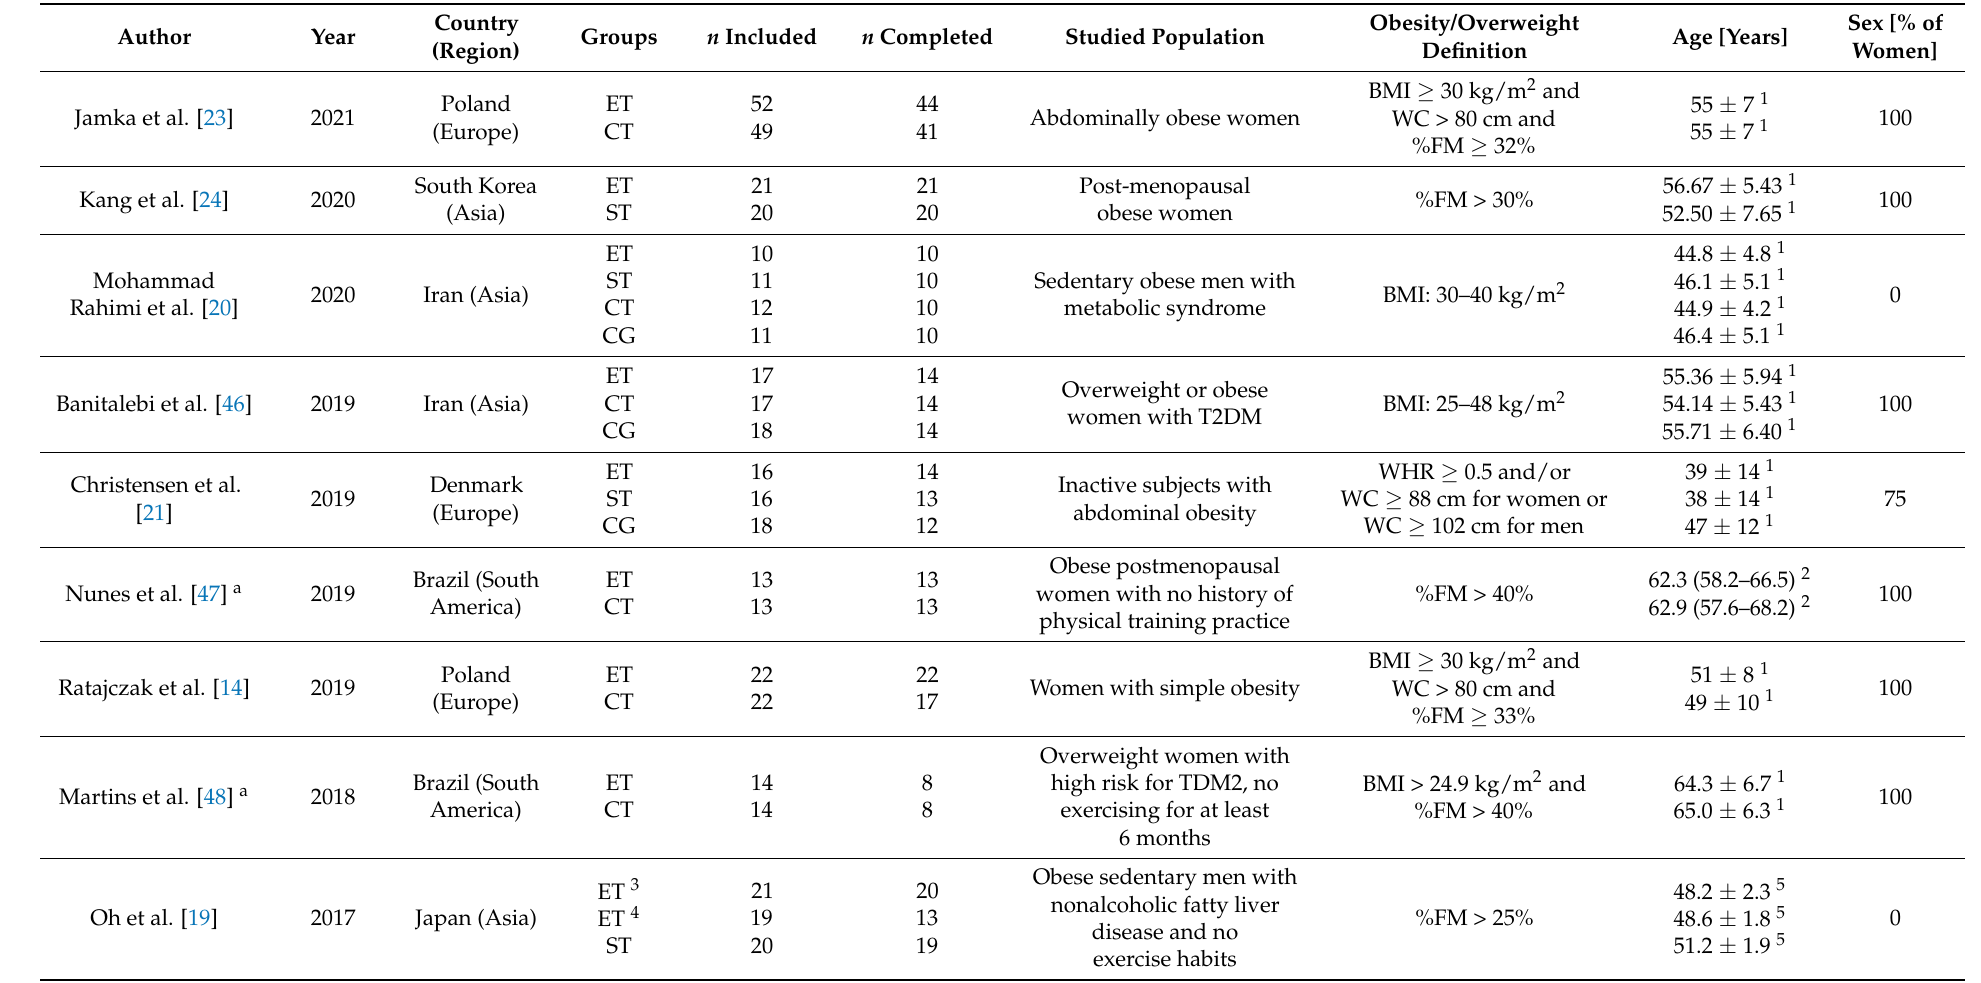
Table 1. Characteristics of included